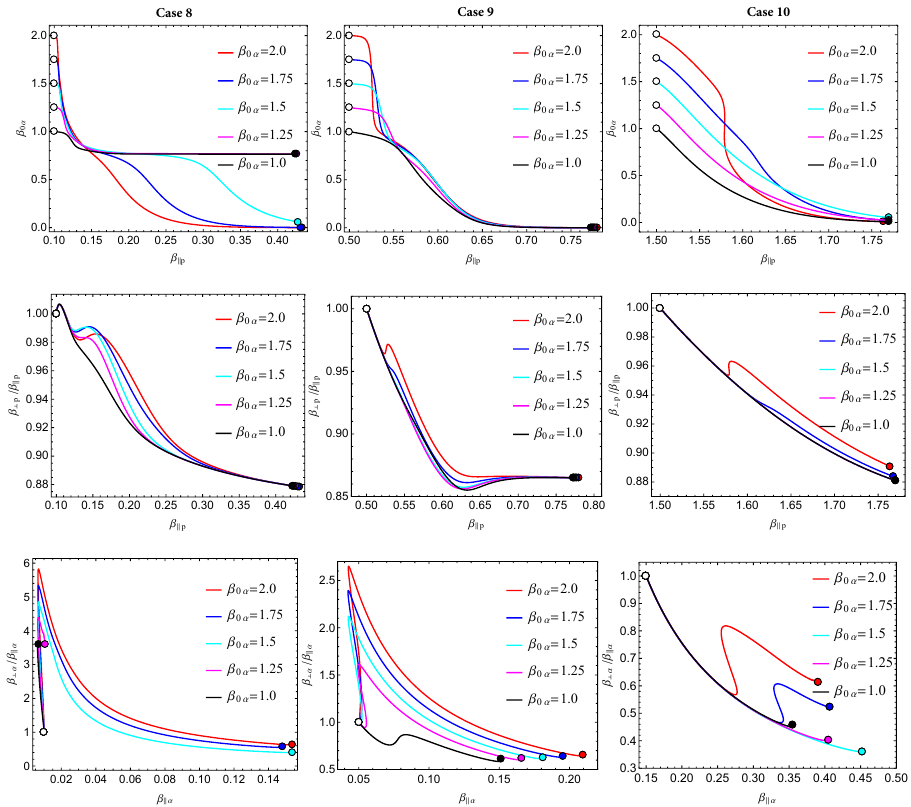
Figure 6. Dynamical evolution of the alpha drift velocity ( top row ), temperature anisotropies of protons ( middle row ) and alpha particles ( bottom row ) as functions of β (cid:107) p ( τ ) (or β (cid:107) α ( τ ) ) for cases 8 ( left column ), 9 ( middle column ), and 10 ( right column ). See text for